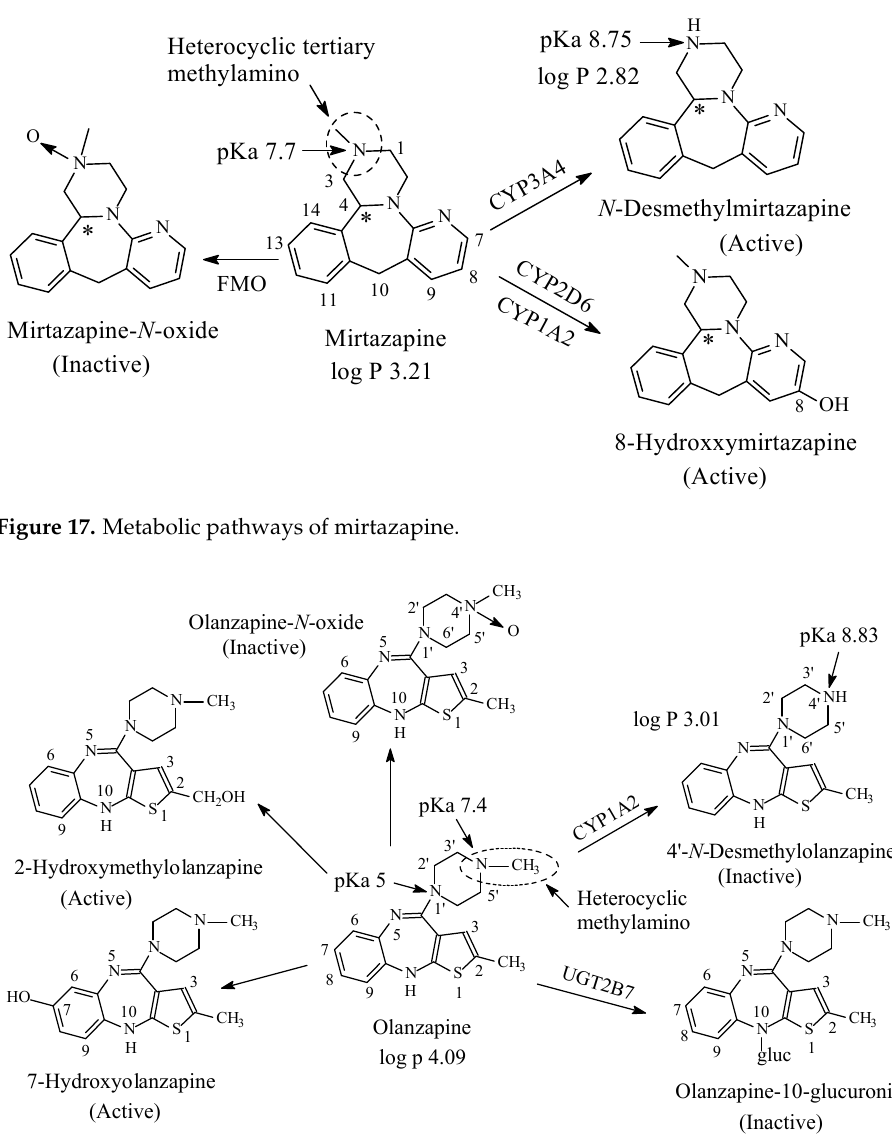
Figure 18. Metabolic pathways of olanzapine.